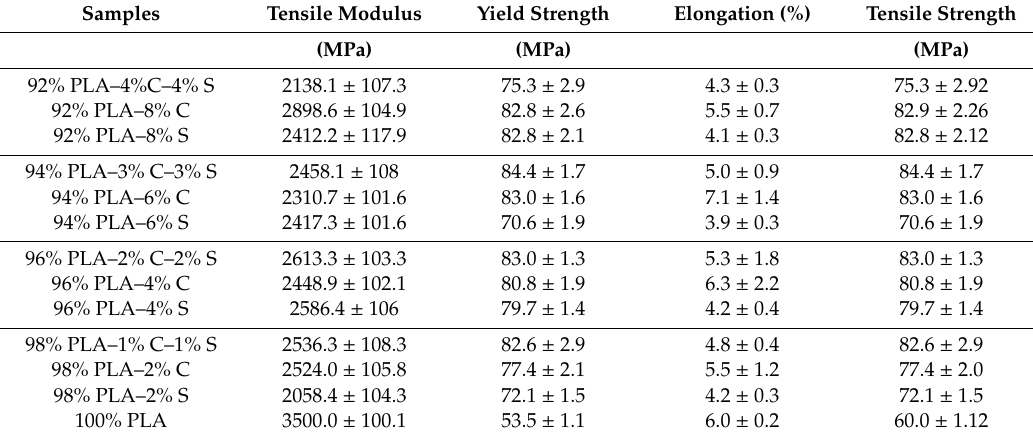
Table 3. Tensile properties of PLA–chitin (C)–starch (S) composites. Samples Tensile Modulus Yield Strength Elongation